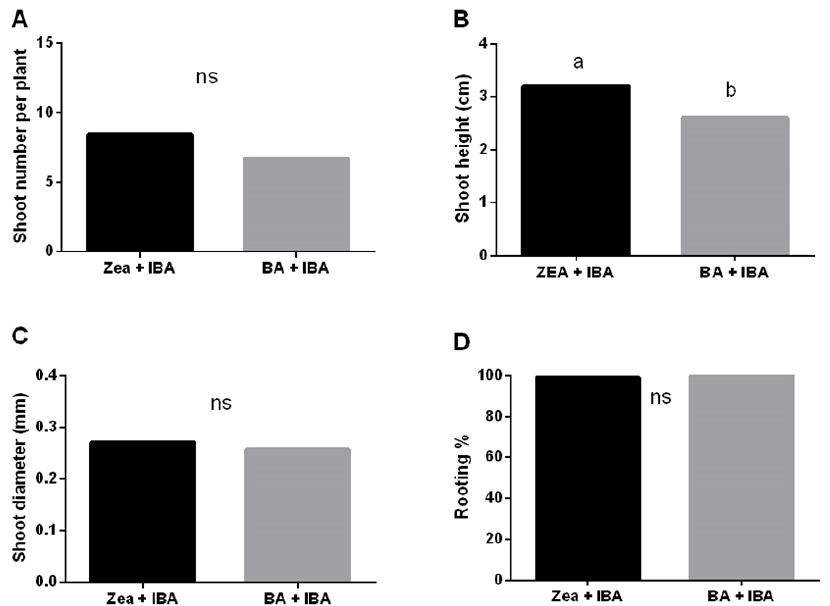
Figure 5. E ff ects of plant growth regulators on shoot propagation of pitaya micropropagated shoots. The parameter considered are: Shoot number per plant ( A ); Shoot height ( B ); Shoot diameter ( C ); Rooting percentage ( D ). For each parameter and each group considered, columns labeled with di ff erent letters are significantly di ff erent (at p < 0.05). Student’s t -test was used to compute the pair-wise comparisons between group means. Abbreviations: 6-benzylaminopurine (BA); Indole − 3-butyric acid (IBA).